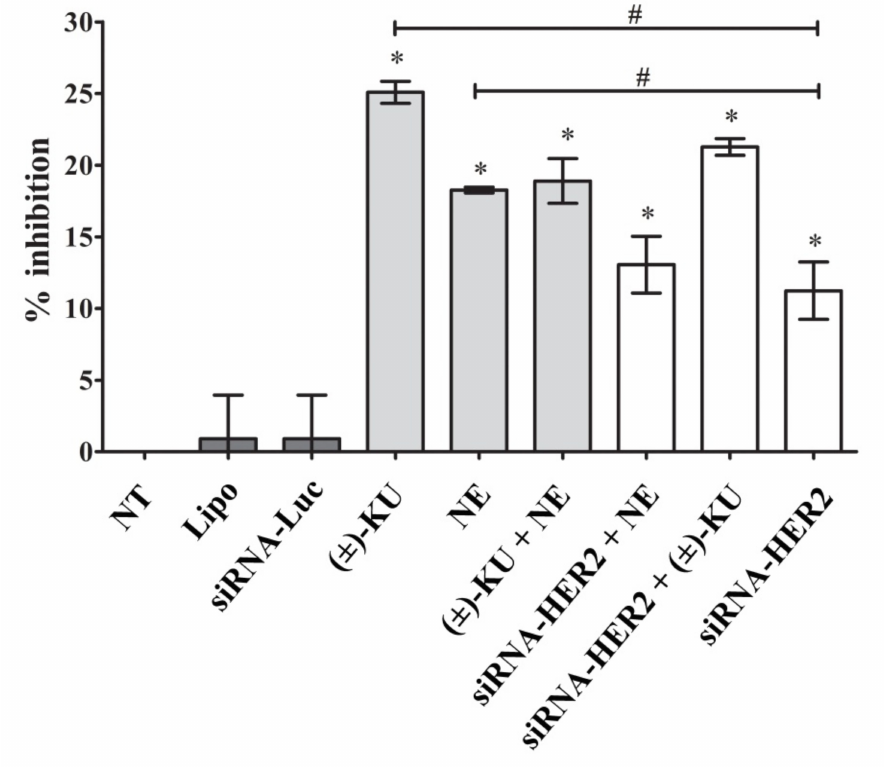
Figure 5. The inhibitory effect of the compounds, siRNA-HER2 and the combination on breast cancer cells. MCF-7 cells were seeded in 48 well plates with 3 × 10 4 cells/well and treated with IC 50 values of tested compounds (4.45 µ Msynthetic ( ± )-kusunokinin, 0.004 µ Mneratinib, or 4.45 µ M ( ± )-kusunokinin combination with 0.004 µ Mneratinib),100 nM siRNA-HER2, and 100 nM siRNA- HER2 combination with IC 50 values of ( ± )-kusunokinin, or neratinib. Cells treated with transfection reagent (lipofectamine), siRNA-Luciferase or non-treated were the control group. Cell viability was investigated using the trypan blue exclusion assay. The percentage of cell inhibition represents the mean ± SD of three independent experiments. The student’s t -test was used for the consideration of p values. * p < 0.05 vs. control and # p < 0.05 vs. siRNA-HER2. NT, non-treated cells; Lipo, lipofextamine; siRNA-Luc, siRNA-Luciferase; ( ± )-KU, ( ± )-kusunokinin; NE, neratinib; ( ± )-+NE, ( ± )-kusunokinin+neratinib; siRNA-HER2+NE, siRNA-HER2+neratinib; siRNA-HER2 + ( ± )-KU, siRNA-HER2 + ( ±